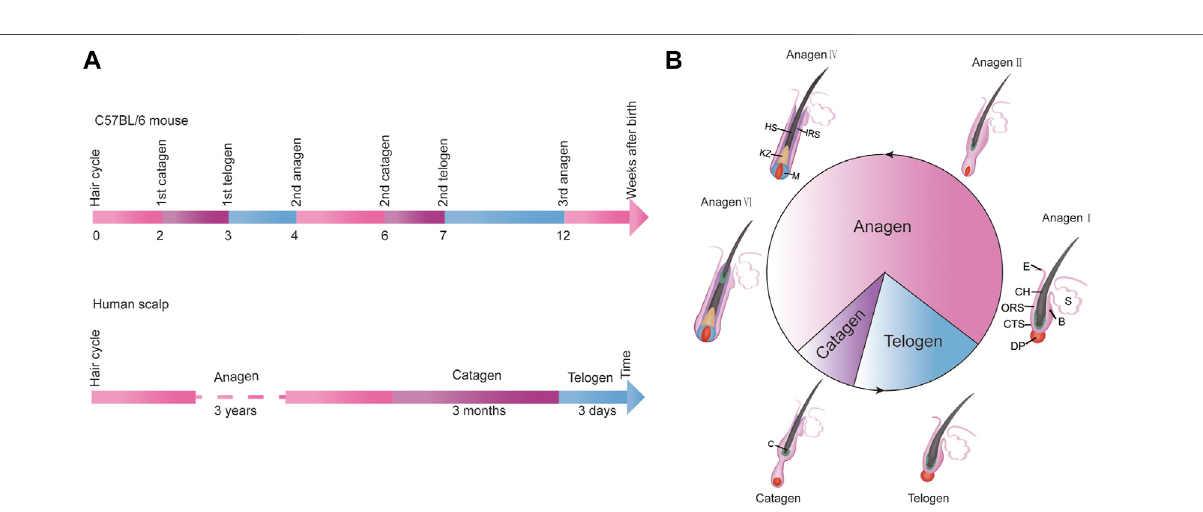
FIGURE 3 | The growth cycle of hair. (A) The time-scale for the hair cycle in female C57BL/6 mice during the fi rst 14 weeks after birth (the upper part); The time- scale for the hair cycle in humans (the lower part). (B) The morphology of hair follicles at different stages of the hair cycle. Anagen: growth phase, catagen: regression phase, telogen: resting